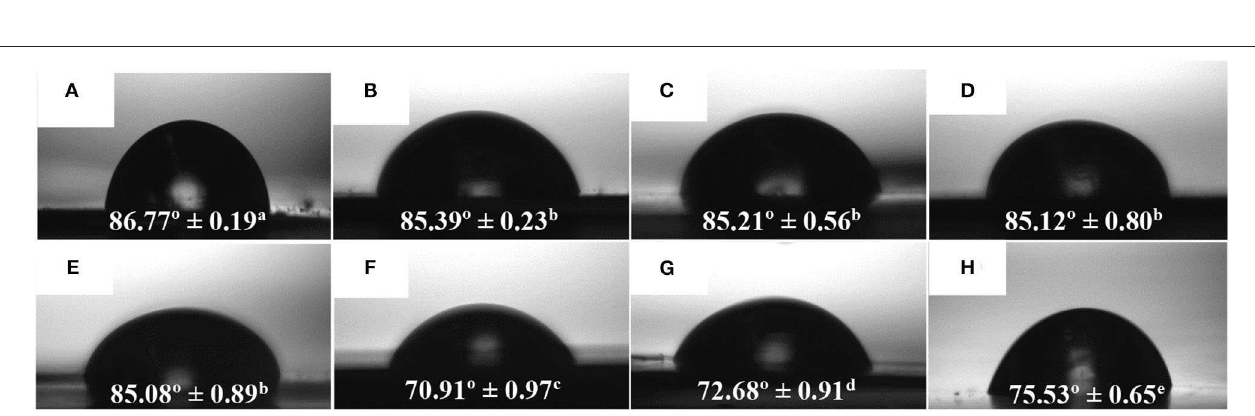
FIGURE 7 | Water contact angle (WCA) of electrospun monolayer films of poly(3-hydroxybutyrate- co -3-hydroxyvalerate) (PHBV) containing eugenol: (A) Neat PHBV; (B) 2.5 wt.%; (C) 5 wt.%; (D) 10 wt.%; (E) 15 wt.%; (F) Food contact layer of PHBV, (G) Structural layer of poly(3-hydroxybutyrate) (PHB); (H) Multilayer containing 15 wt.% eugenol measured on the food contact layer side. ( a − e ) Different superscripts indicate significant differences among samples ( p <